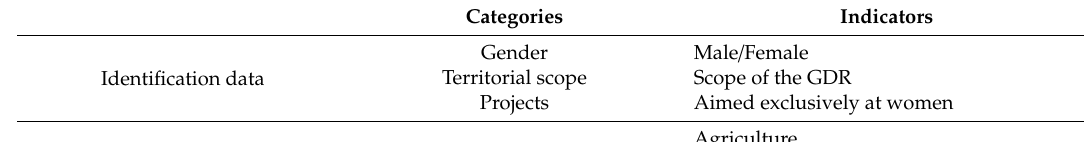
Table 2. Analytical dimensions, categories and